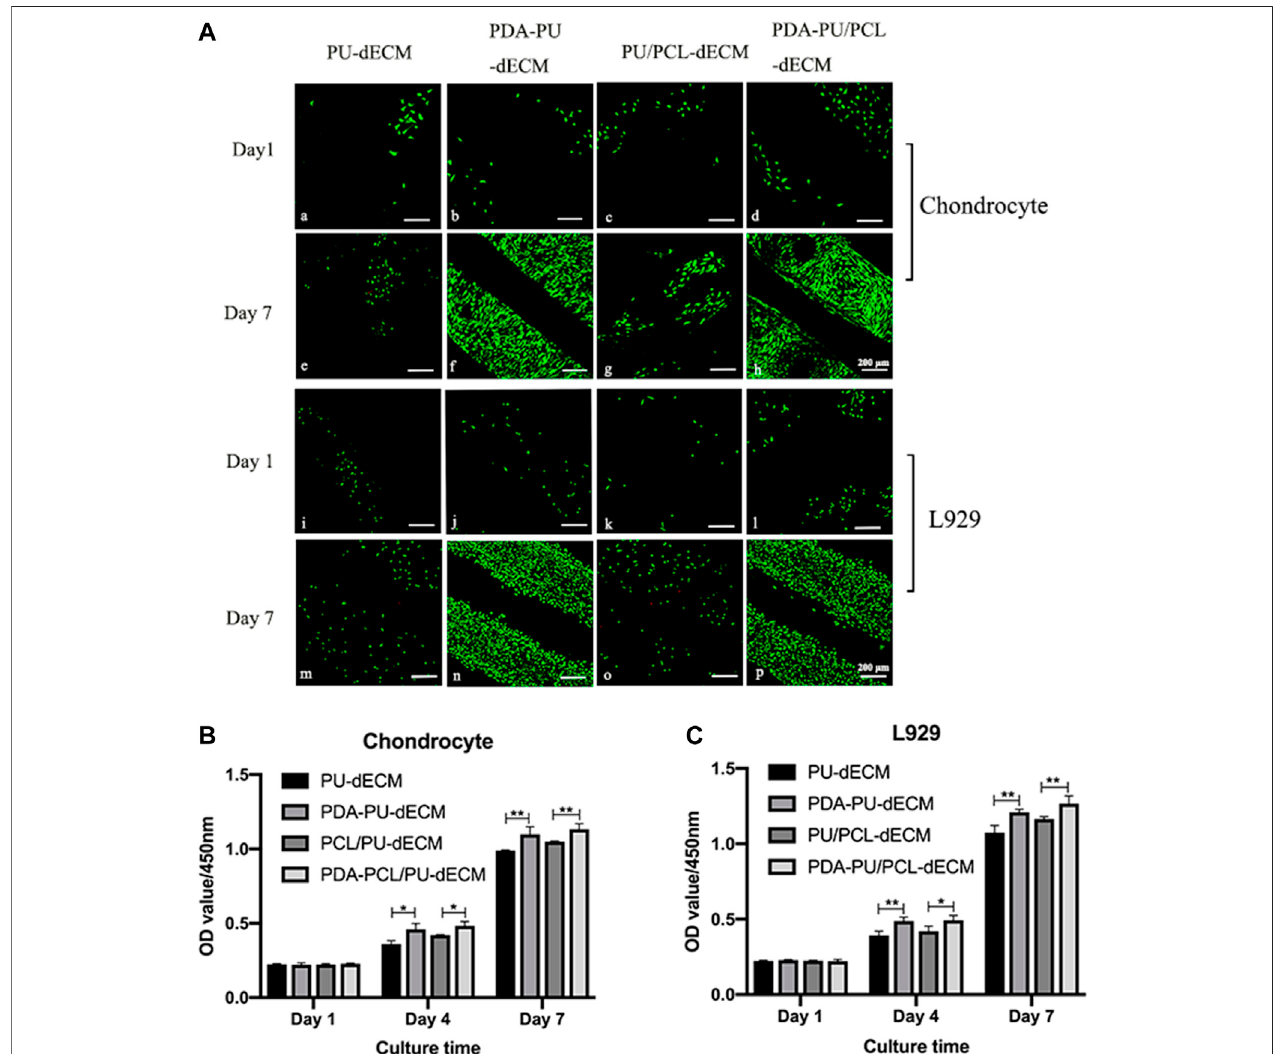
FIGURE 4 | Cell viability of the scaffolds. (A) LIVE/DEAD staining of the scaffolds: (a)-(h) chondrocyte, (i)-(p) L929. (B,C) Cell proliferation of the scaffolds. (*Comparison between original groups and modi fi ed groups, n (cid:2) 3, * p < 0.05, ** p < 0.01).